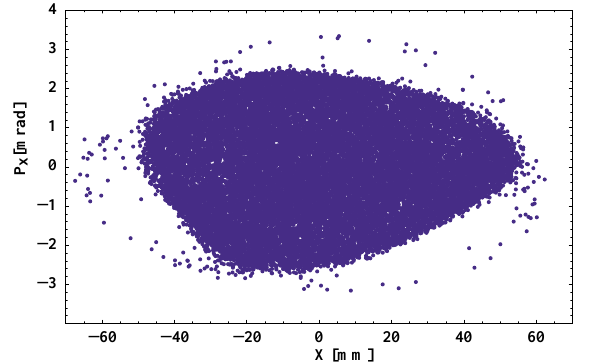
FIG. 14. (Color) X - P x phase-space plot at 375 turns for (cid:2) (cid:1) (cid:1) 5.82, 5.86 (cid:2) (cid:1) n x , n y